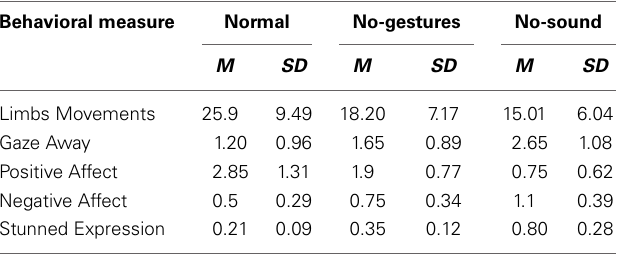
Table 3 | Means and standard deviations of relative behavioral